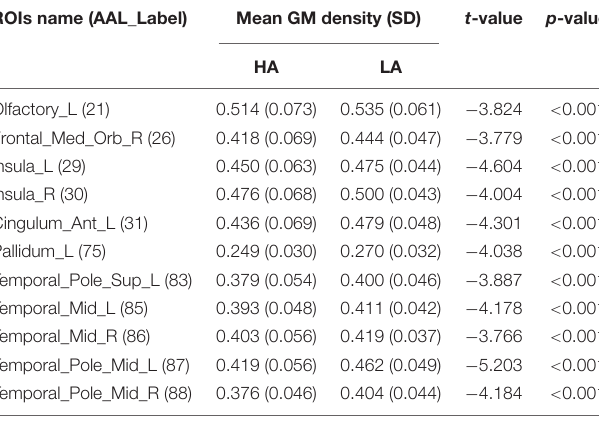
TABLE 3 | Comparison of average gray matter density in each brain area between the two groups.